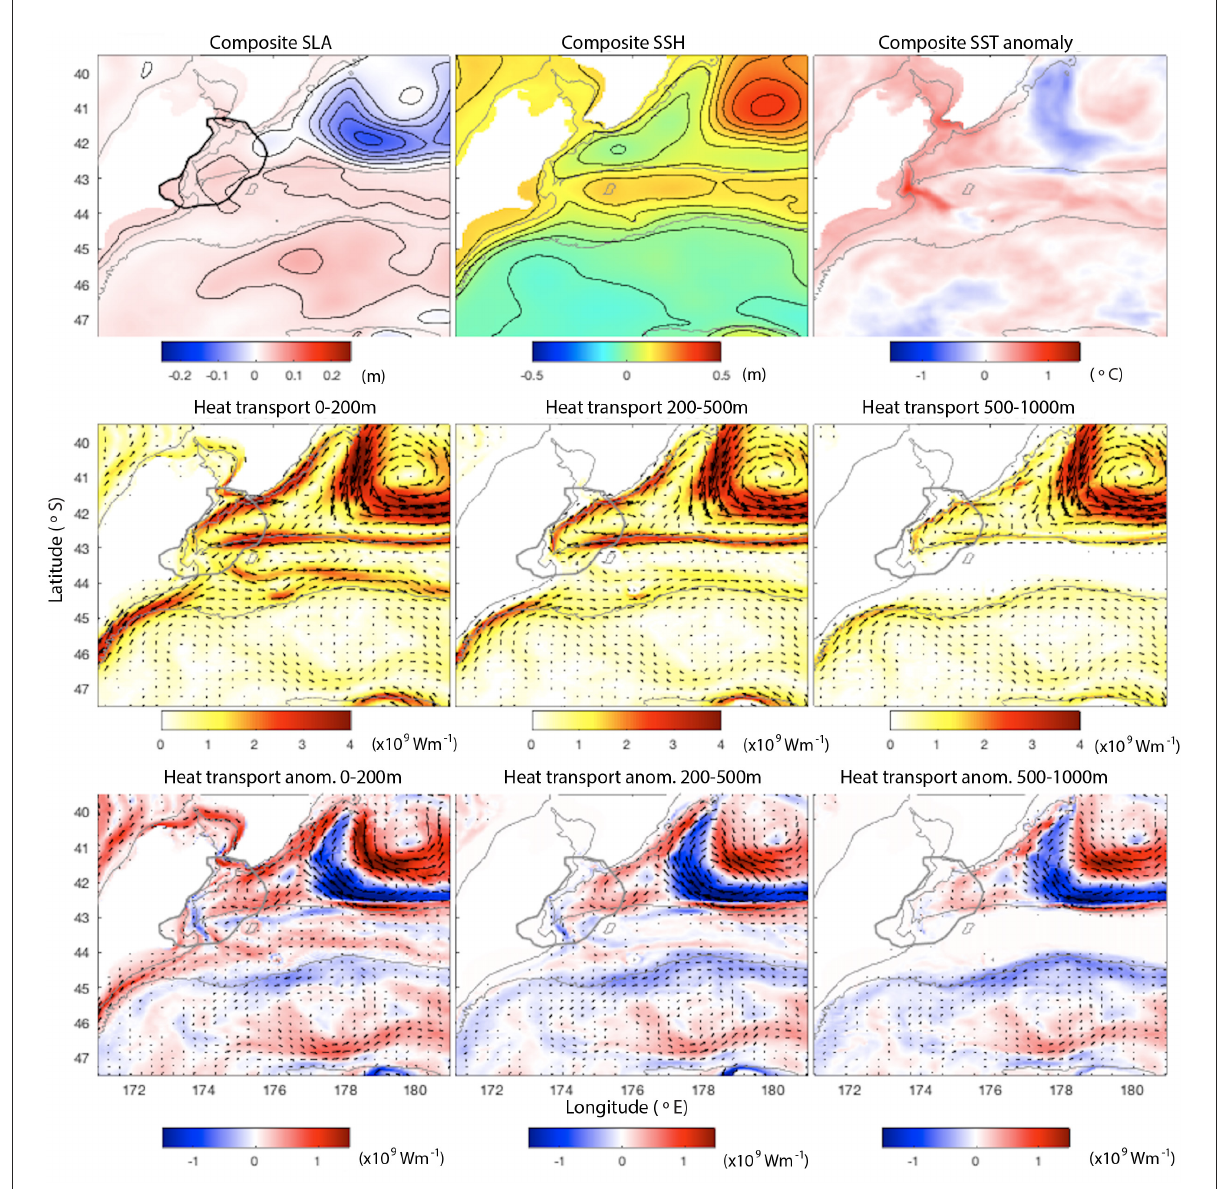
FIGURE9 (Top) : Ensemble means of SSH anomaly, SSH and SST anomaly averaged over the 4 days leading up to all 64 MHW events in the Kaikoura region. (Middle) : Ensemble means of depth-integrated heat transport averaged over the 4 days leading up to MHW events from 0 to 200, 200 to 500, and 500 to 1,000 m (Wm − 1 ). (Bottom) : Ensemble means of depth-integrated heat transport anomalies (Wm − 1 ). Gray lines show the 100 and 1,000 m bathymetry